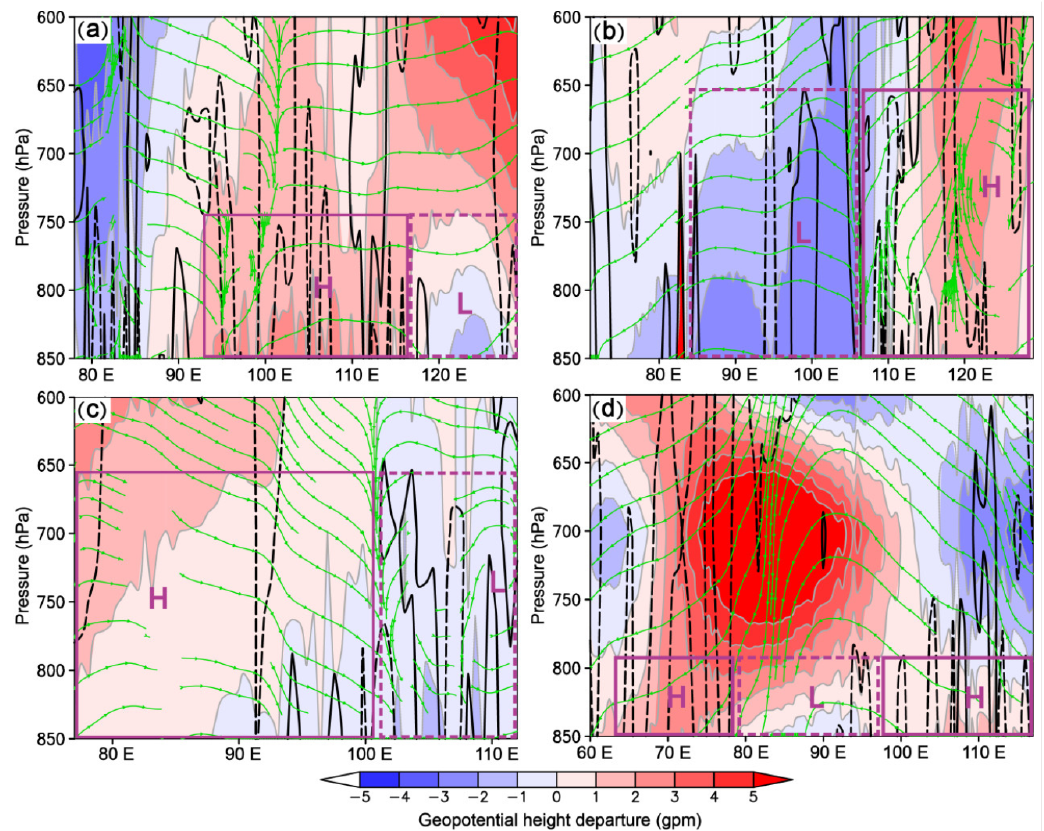
Figure 6. Vertical cross-sections of the vorticity differences (solid and dashed lines are, respectively, for the vorticity contours of 0.2 × 10 − 5 and − 0.2 × 10 − 5 s − 1 ) and the longitudinal anomalies of the geopotential height difference (shaded; units: gpm) between the ECMWF-predicted and the reanalyzed along the curves around the Mongolian Plateau as are shown in Figure 4a–d. The solid frame “H” and dashed frame “L” in each panel of ( a – d ) mark, respectively, the high and low value centers of the longitudinal anomaly of geopotential height differences in Figure